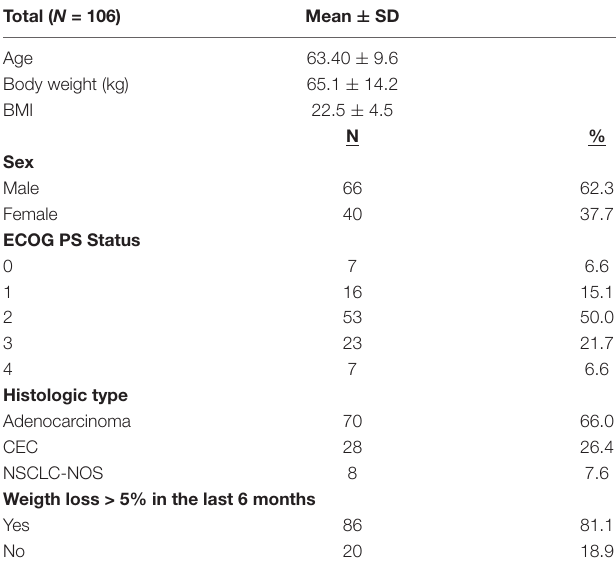
TABLE 1 | Baseline characteristics of the study